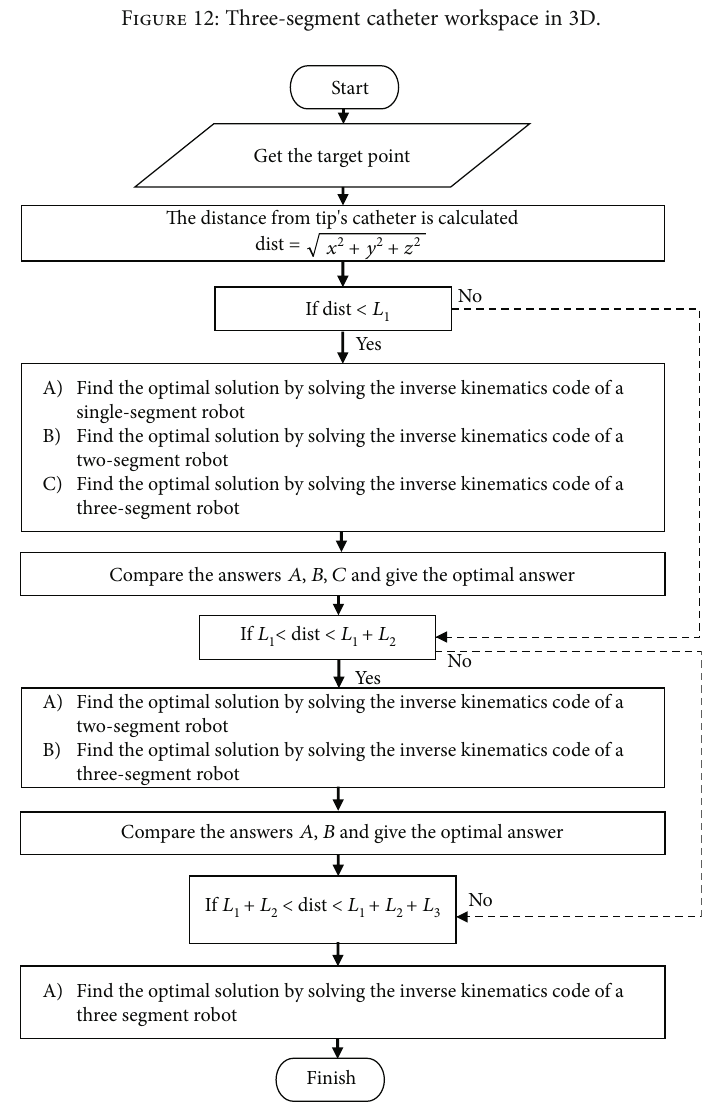
Figure 13: Flow chart for fi nding an optimal inverse